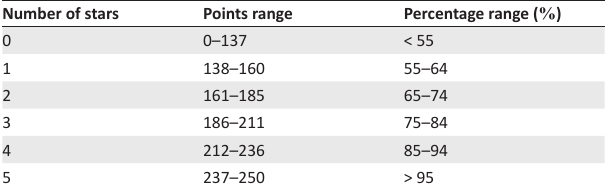
TABLE 4b: Summary of WHO AFRO SLIPTA checklist that covers the 12 Quality System Essentials and the weighted marks of each section out of the 250 total points.